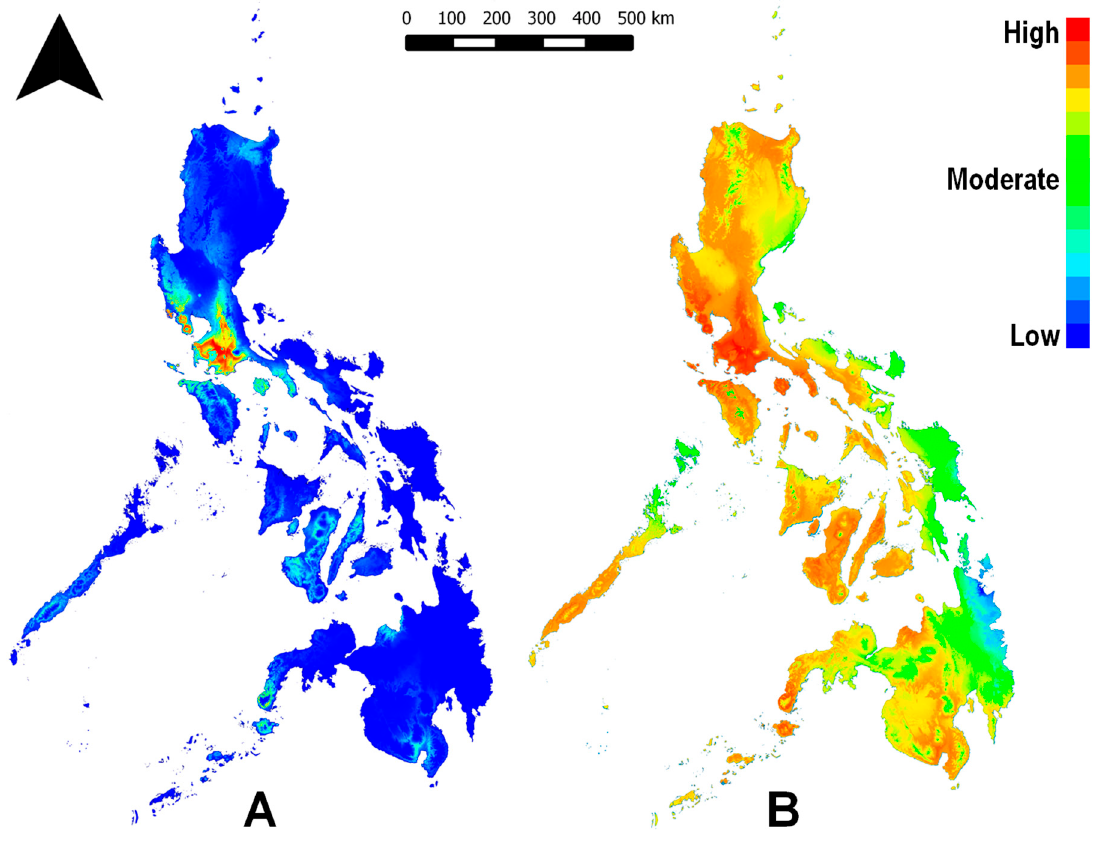
Figure 1. Bioclimate-based species distribution model (SDM) for Comperiella calauanica in logistic ( A ) and raw ( B ) expressions of calculated probabilities. Warmth of color indicates relative probability of occurrence or suitability of habitat.